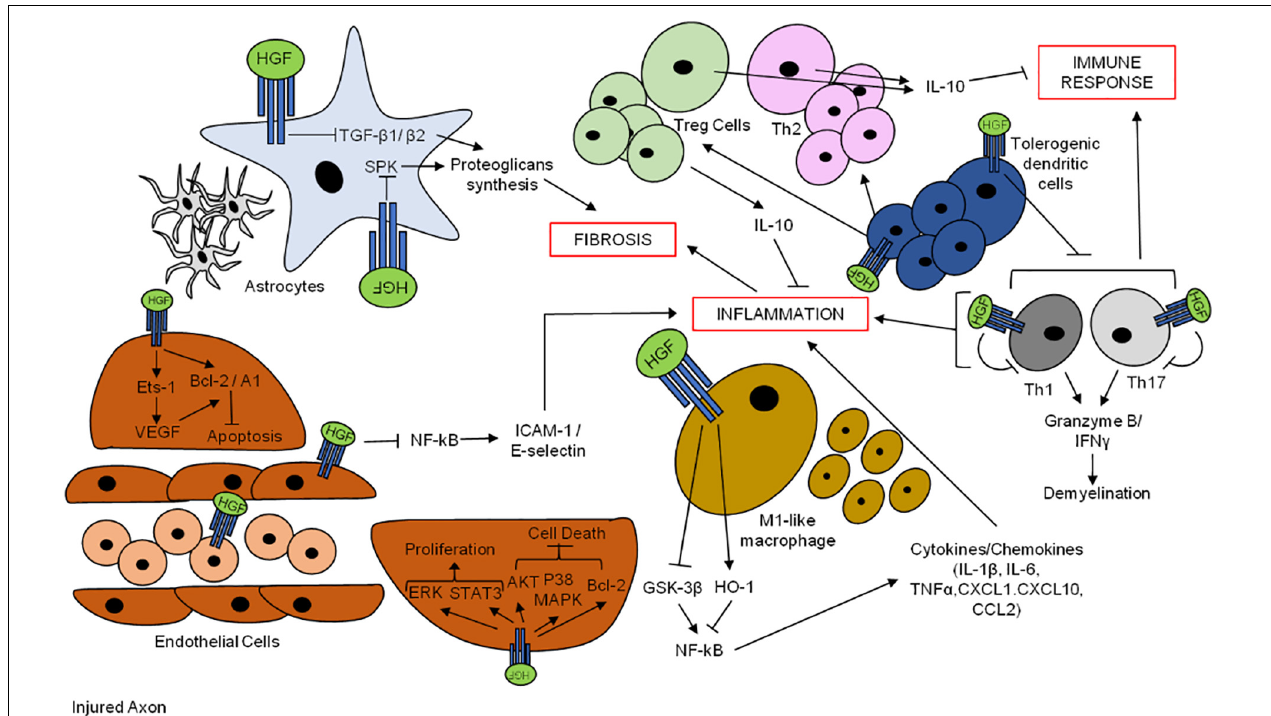
FIGURE 5 | Hepatocyte growth factor promotes neuron survival after brain injuries. HGF-MET pair exerts anti-fibrotic and anti-inflammatory effects through the promotion of neuro-angiogenesis and modulation of the immune